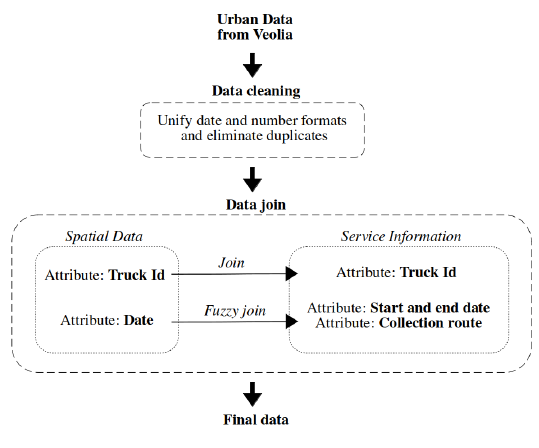
Figure 4. Steps in data pre-processing.